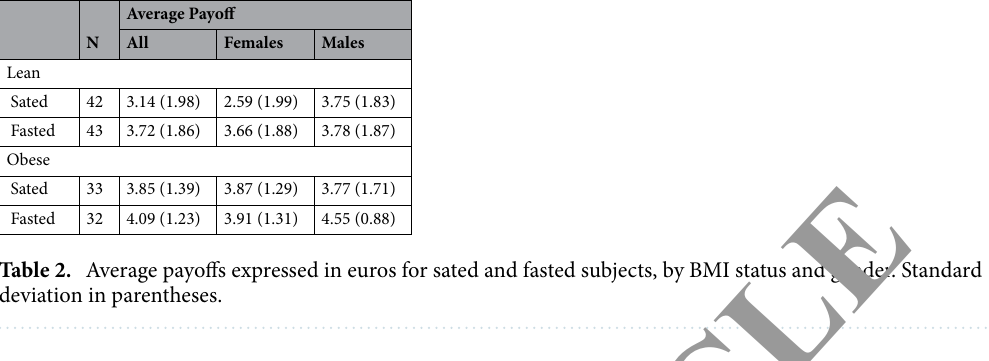
subjects when fasted differs significantly from a uniform distribution ( χ 2 test: p = 0.001). Subjects significantly under-report the lower outcome (blue: 16.28%, binomial test p = 0.015) and over-report the higher outcome (red: 60.47%, p < 0.001), while the medium outcome is reported less than expected but not significantly so (yellow: 23.26%, p = 0.196). This suggests that breakfast consumption by lean subjects is associated with more honest behaviour. The effect of breakfast manipulation in lean subjects appears to be mainly due to females: lean females report significantly more the higher outcome when fasted compared to when sated (Fisher tests p = 0.042). Results differ for obese subjects, who lie regardless of breakfast manipulation. As found for lean subjects, the distribution of outcomes reported by fasted obese participants remains significantly different from a uniform distribution ( χ 2 test: p = 0.001). Indeed, these subjects significantly under-report the lower outcome (3.12%, binomial test p < 0.001) and over-report the higher outcome (59.38%, p = 0.004), while the frequency of the medium outcome does not differ from chance (37.50%, p = 0.708). However, in contrast to lean subjects, the distribution of outcomes reported by sated obese participants is significantly different from a uniform distribution ( χ 2 test: p = 0.008). Accordingly, the frequencies of the lower and higher reported outcomes differ significantly from chance: blue is reported in 6.06% of the observations ( p < 0.001) and red in 51.52% ( p = 0.040). Yellow is reported 42.42% of the time, which does not differ from chance level ( p = 0.273). Comparing the behaviour of obese and lean subjects when fasted or sated reveals that obese subjects tend to lie more on (by reporting less often) the lower outcome than their lean counterparts when sated (two-sided Fisher test: p = 0.056), while no significant difference is found for the medium and higher outcomes. This difference between obese and lean subjects is driven by the female sub-sample ( p = 0.020), while no significant difference is found for males. No significant difference is found between lean and obese subjects when fasted, suggesting that hunger reduces the heterogeneity in behavioural responses (see Supplementary Table S4 for full results). Lying to maximize payoff or to avoid lowest payoff?.